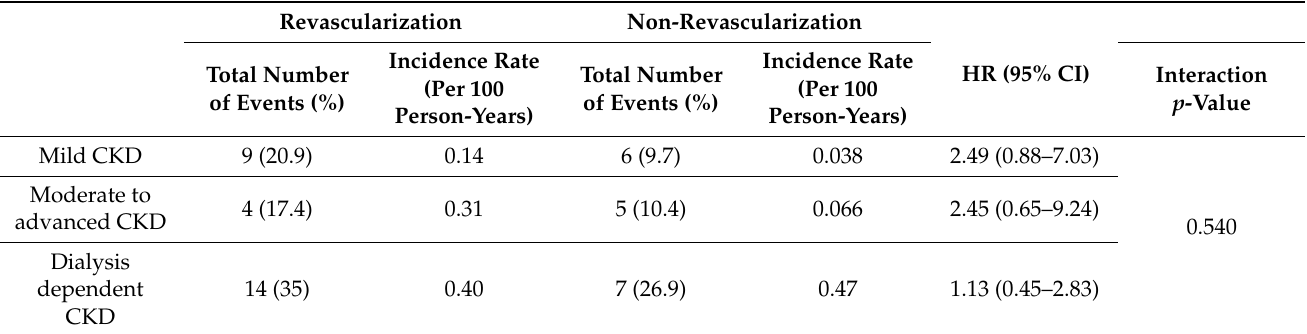
Table 4. Incidence of the composite outcome and hazard ratio of FFR-guided treatment strategy in CKD population, stratified by mild CKD, moderate to advanced CKD and dialysis dependent